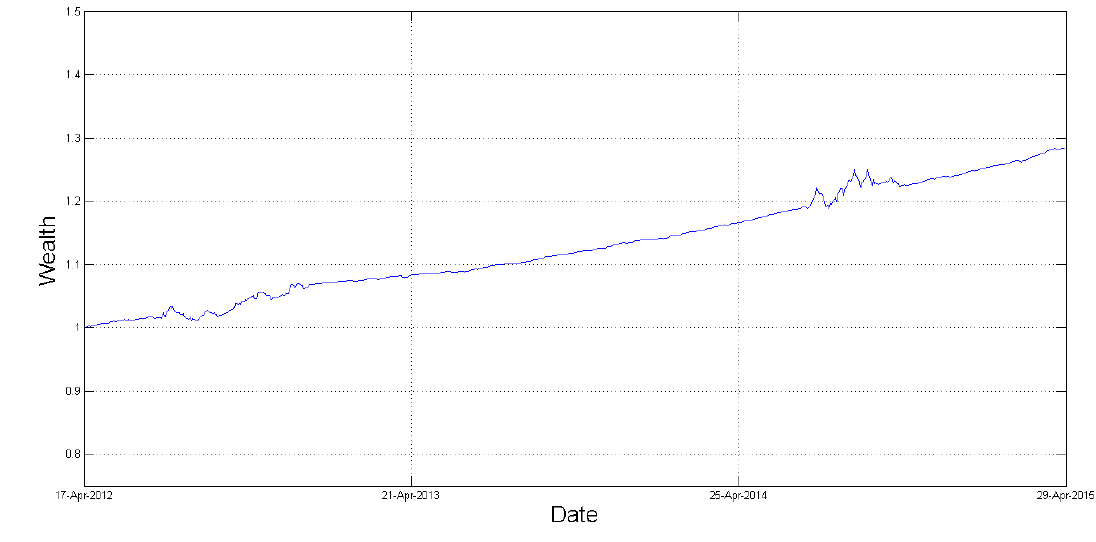
Figure 6. Ex-post wealth on Brazilian bonds after second